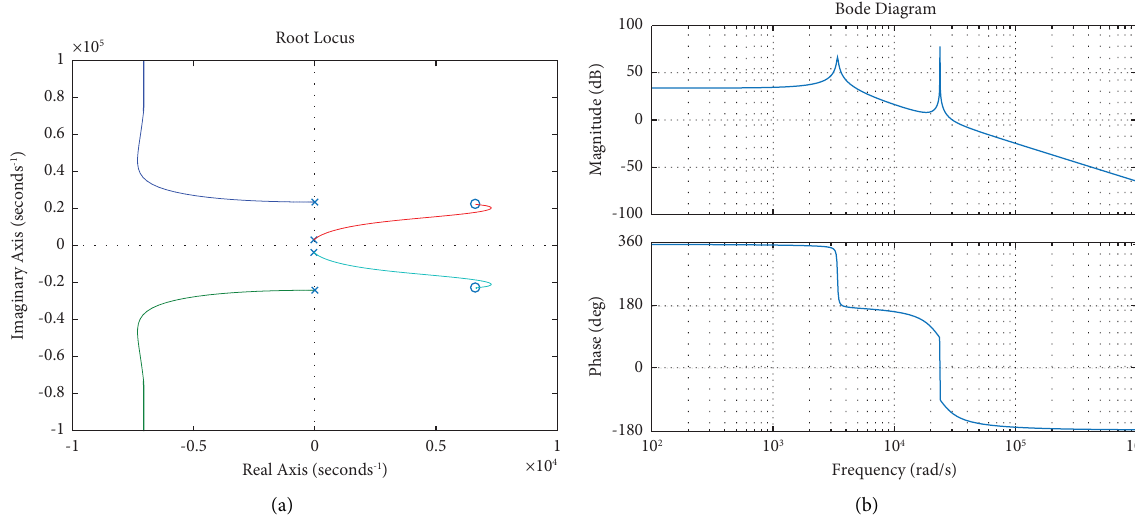
Figure 3: Cuk converter: (a) root locus diagram; (b) bode